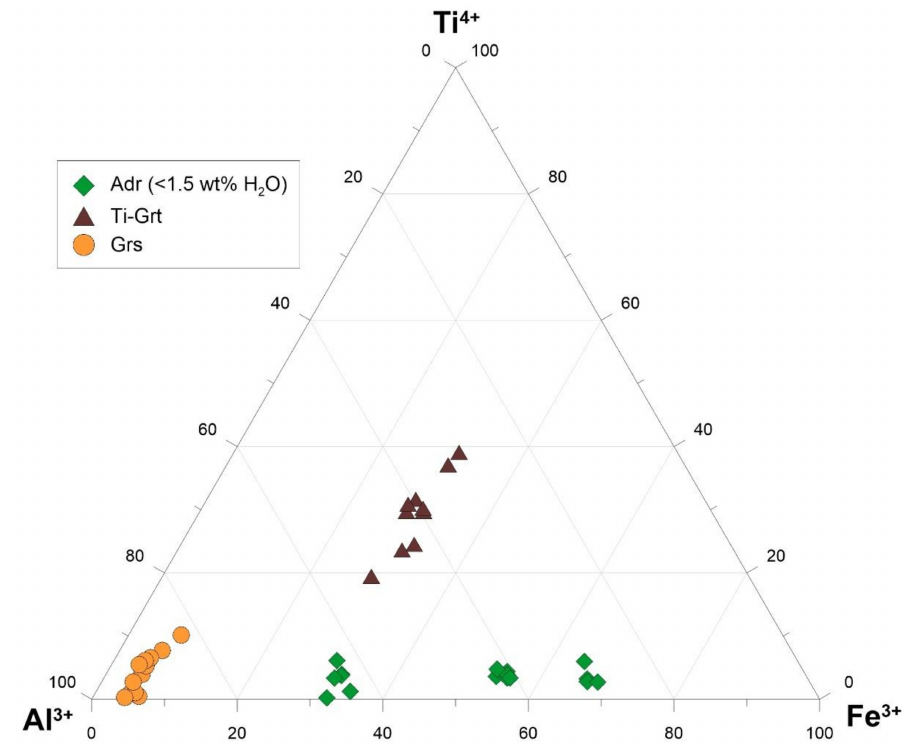
Figure 5. Chemical variations of the garnet solid solution projected into Fe 3+ -Ti-Al ternary diagram. The low hydrated Adr group represents younger rims of otherwise hydrated garnet cores.